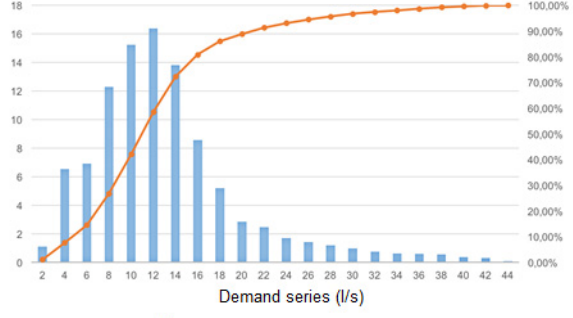
12 of 29 Figure 7. Annual flow pattern in Beloura DMA.